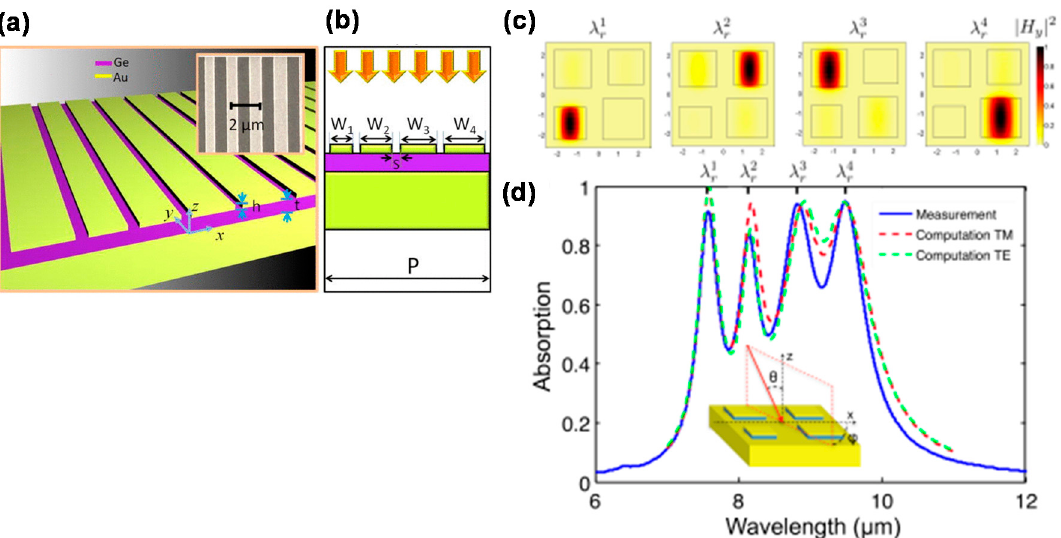
Figure 8. Schematic illustrations of MIM ‐ PMAs with multi ‐ size micropatches having ( a , b ) 1D and ( c ) 2D periodic configurations. ( d ) Calculated and measured absorption spectra for the 2D periodic configuration. ( a , b ) are reprinted from Reference [65] with the permission of AIP Publishing. ( c , d ) are adapted with permission from Reference [66]. © 2012 Optical Society of America.